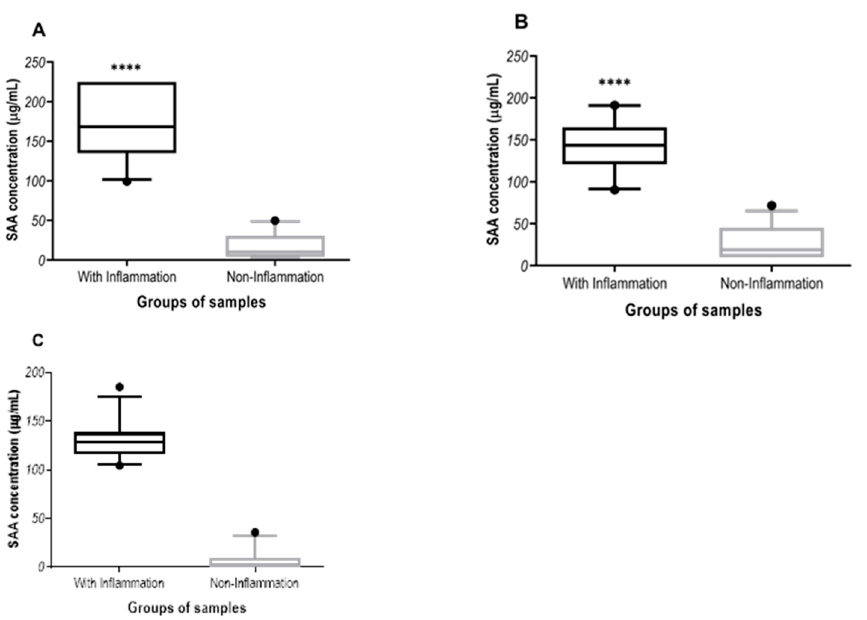
Figure 2. Serum Amyloid A concentrations in cats with different inflammatory diseases (n = 25) and cats from non-inflammatory diseases (n = 26) measured in Fuji ( A ), CUBE-VET ( B ) and Eiken ( C ) assay method. The plots show median (line within box), 25th and 75th percentiles (box) and 5th and 95th percentiles (whiskers). Asterisks indicated significant differences between groups: **** p < 0.0001.